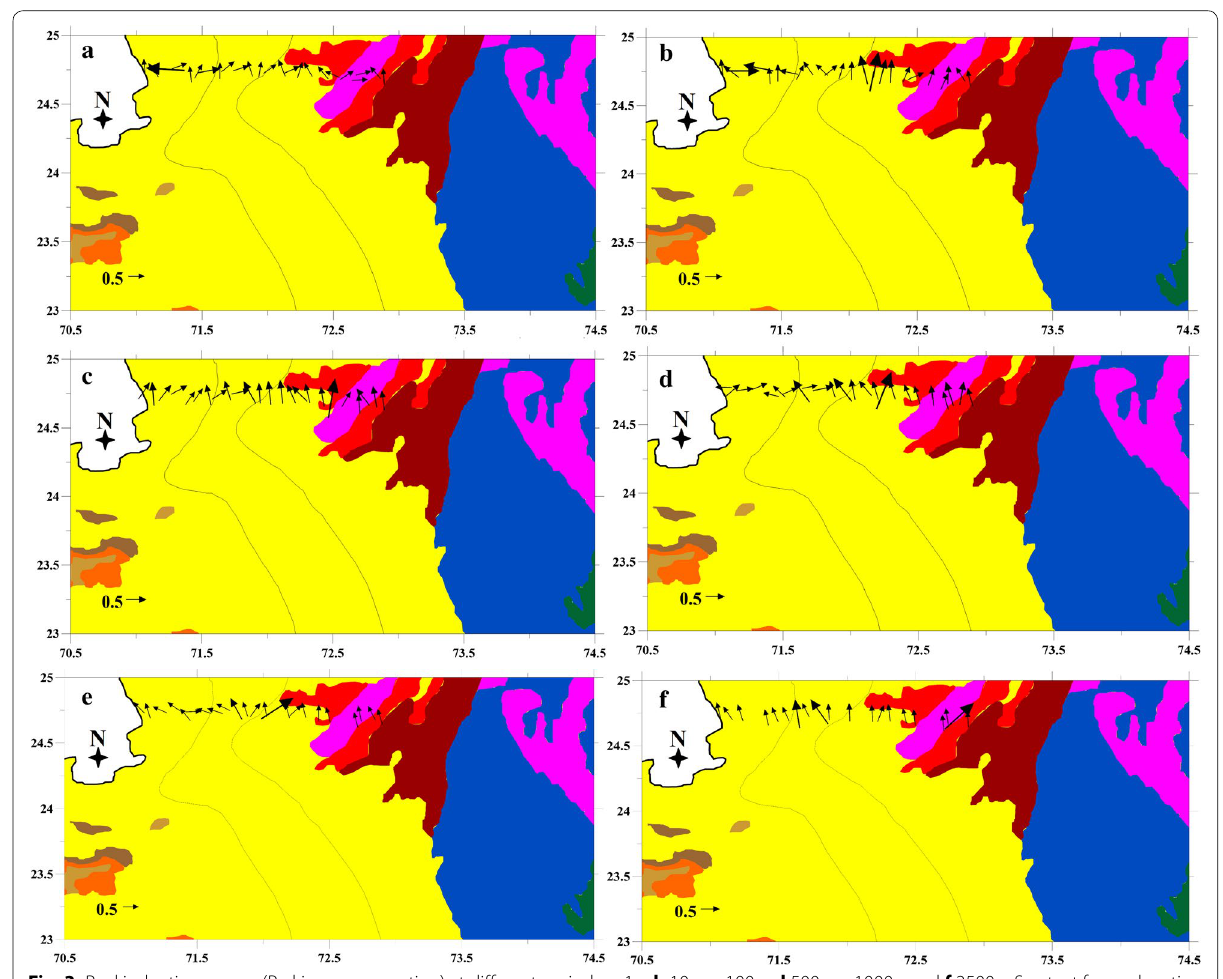
Fig. 3 Real induction arrows (Parkinson convention) at different periods. a 1 s, b 10 s, c , 100 s, d 500 s, e 1000 s and f 2500 s. See text for